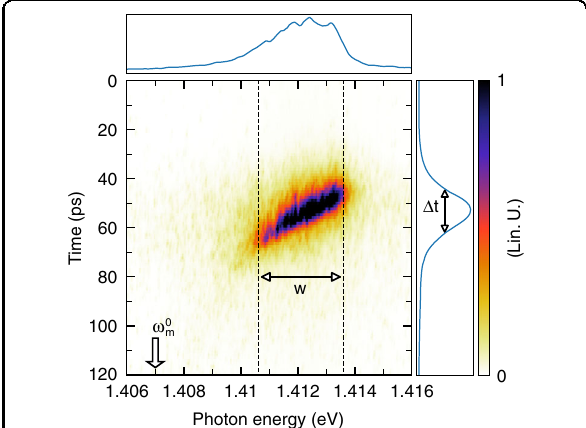
Fig. 9 Temporal and spectral analysis of the light pulses emitted by QDs in a switched QDM. Streak camera image obtained for light pulses emitted by a sub-ensemble of QDs in a switched QDM that have been frequency-selected using a pass-band fi lter (2 μ m diameter, = 1.407 eV, (cid:1) h ω = 1.412 eV, w = 3 meV), during its transient (cid:1) h ω (cid:4) w m coupling with the fundamental mode of the cavity. The pump beam is matched to the top facet of the QDM, E p = 1.6 eV, P = 50 pJ/pulse and S = 8 meV. The PL spectrum (top panel) and the temporal PL pro fi le (right panel) are shown in linear scale, and have been, respectively, obtained from the bare image by summing the PL signal over all times and all photon